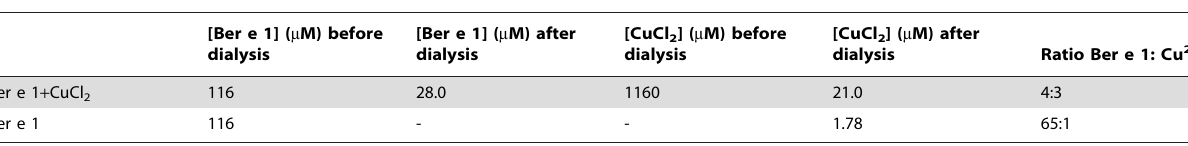
Table 2. ICP analysis of Cu 2 +